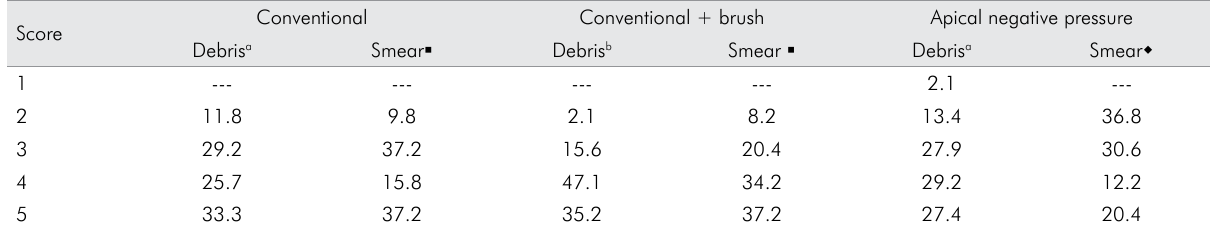
Table 2. Scores (%) for the debris and smear layer removal using each irrigation/aspiration